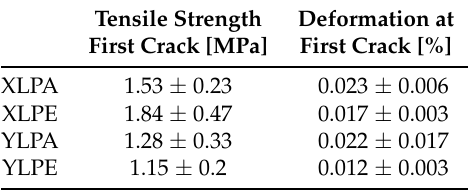
Figure 7. Stress–strain curves of specimens cured for 35 days resulting from uniaxial tensile tests in LPA. ( a ) XVA3PVA20; ( b ) YVA4PVA20-S05. Table 4. Mechanical performance at the first crack of printed composites.